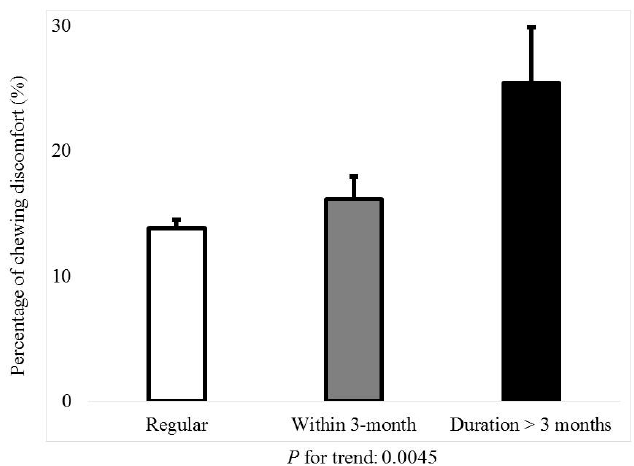
Figure 3. Percentage of chewing discomfort by menstrual cycle irregularity.